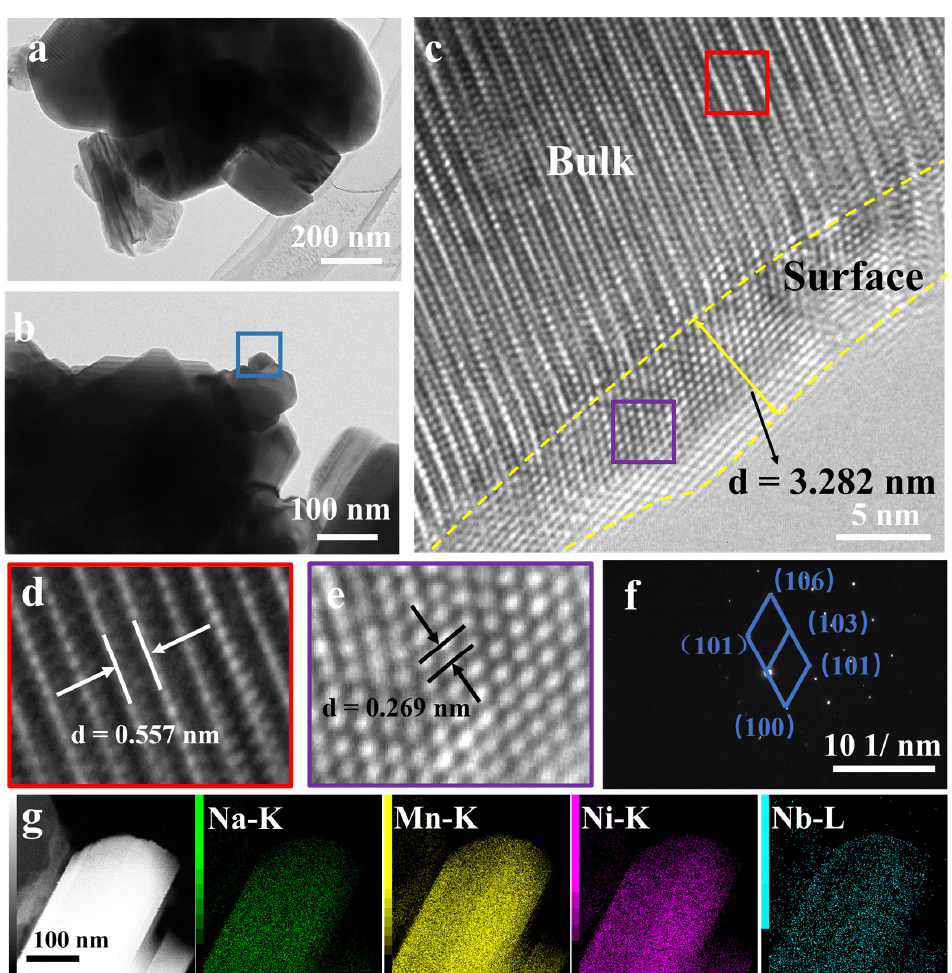
Figure 4. ( a , b ) The TEM and ( c ) the HRTEM of P2-Na 0.67 MNNb. Enlarged images of the ( d ) red and ( e ) purple boxes in ( c ). ( f ) SAED pattern of P2-Na 0.67 MNNb (the SAED pattern was selected from the blue box in ( b )). ( g ) HAADF-EDS elemental mappings of P2-Na 0.67 MNNb (including Na-K edge, Mn-K edge, Ni-K edge and Nb-L edge).